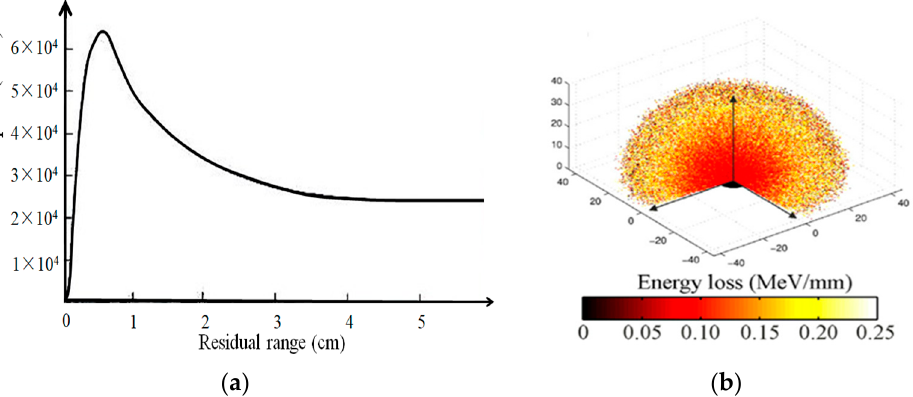
Figure 1. Comparison of Bragg curves of α particles emitted by 210 Po and simulation of the 3D tra- jectory of α particles emitted by 239 Pu. ( a ) Bragg curves for α particles emitted by 210 Po ( b ) Simula- tion of 3D trajectories for α particles emitted by 239 Pu [58]. Figure 1b reprinted with the permission of Elsevier.